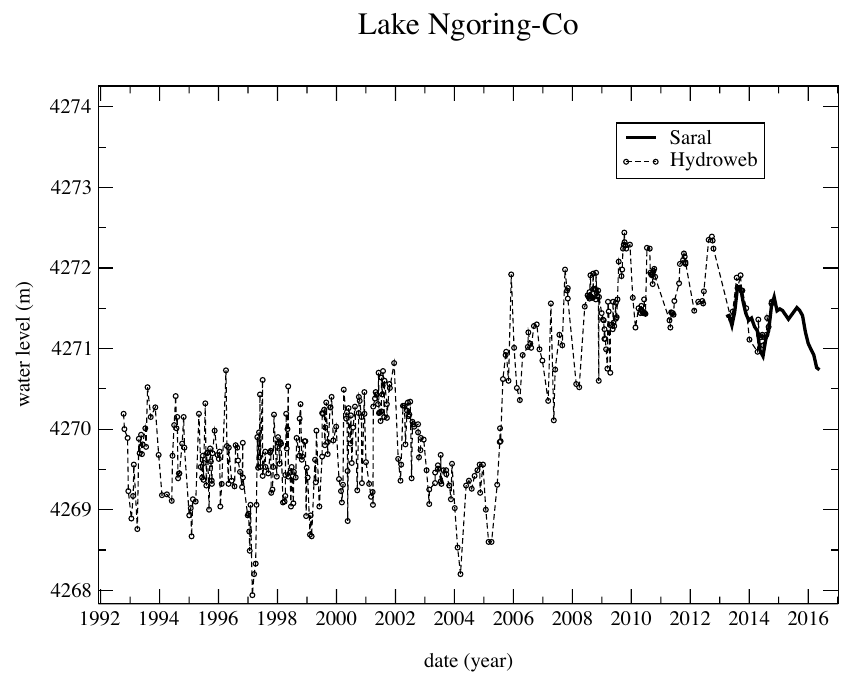
Figure 21. Water level change of Ngoring-Co Lake from a multi-satellite data processing. The lake was at equilibrium between 1992 and 2005 and has suddenly grown since 2006 to reach in a short time a new equilibrium, which slightly decreased after 2013 (extracted from Hydroweb database http://hydroweb.theia-land.fr/ and from SARAL/AltiKa data processing for the period